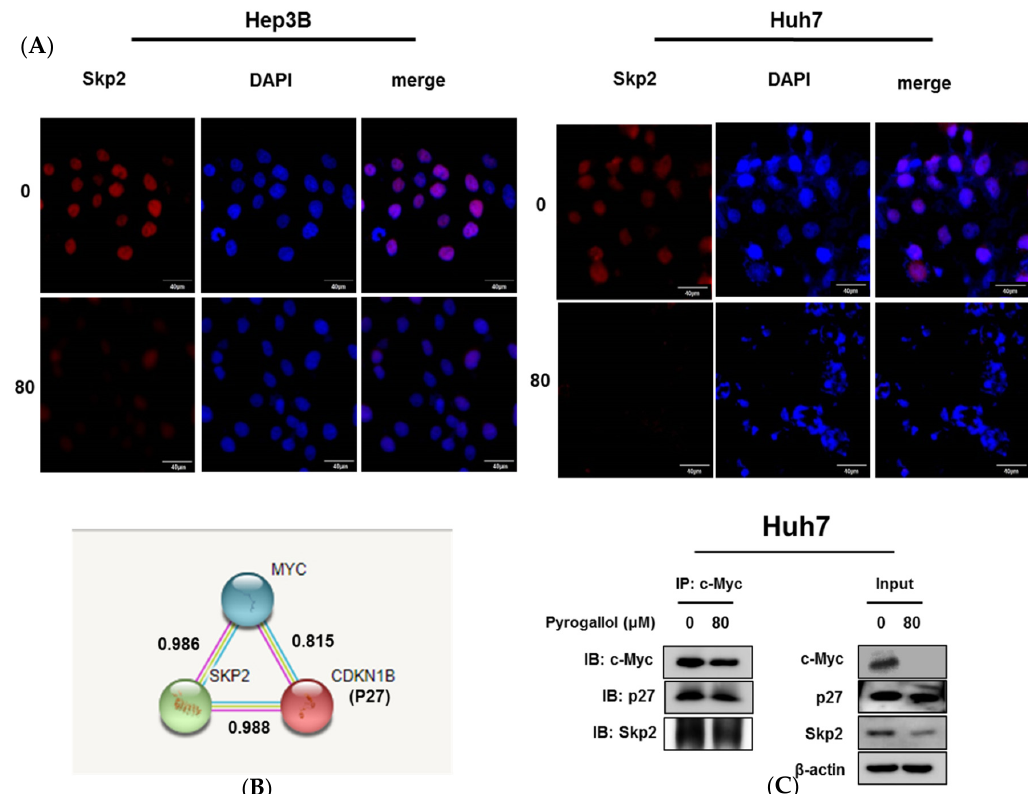
Figure 5. Pyrogallol reduced the expression of Skp2 and disturbed the interaction between Skp2 and c-Myc in Huh7 cells. ( A ) Effect of Pyrogallol on Skp2 expression in Hep3B and Huh7 cells. The cells were treated with 80 μ M Pyrogallol for 24 h, fixed, permeabilized, and then probed with Skp2 antibody and with secondary (FITC) antibody and were stained with DAPI and mounted in media, and visualized under the FLUOVIEW FV10i confocal microscope (Olympuse, Japan). Scale bars= 40 μ m. ( B ) Interaction Network scores between c-Myc and Skp2 by STRING. ( C ) Effect of Pyrogallol on the interaction between Skp2, p27, and c-Myc in Huh7 cells. Immunoprecipitation was performed in Huh7 cells by using c-Myc, p27, and Skp2 antibodies and then was subjected to Western blotting.